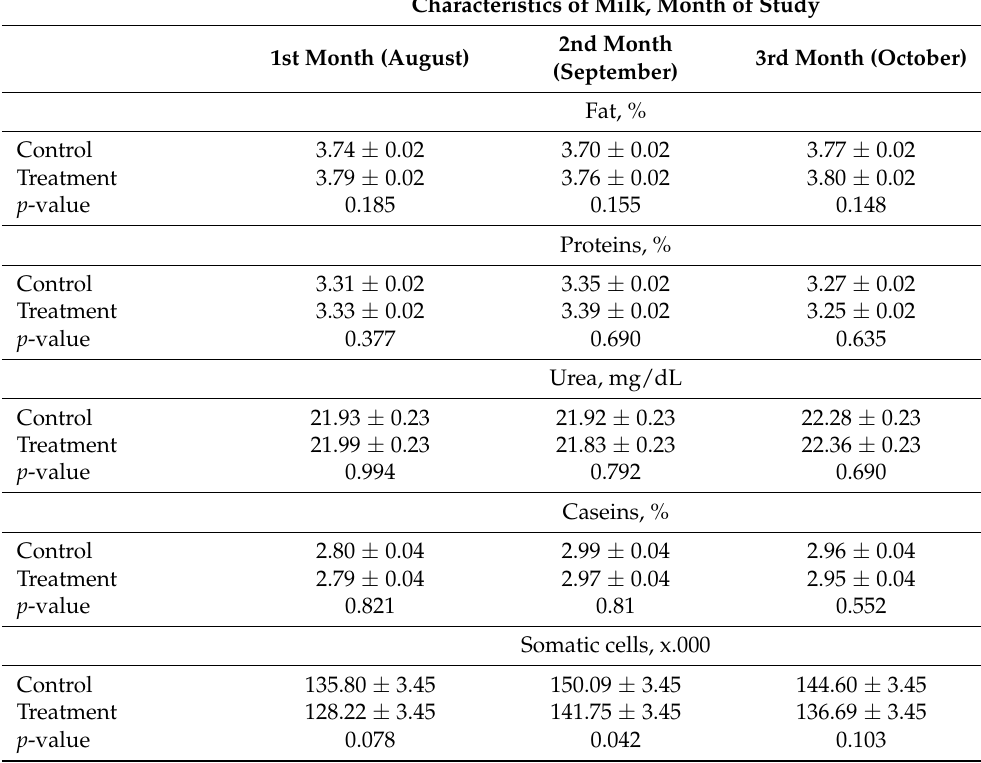
Table 8. Milk quality parameters in Control and Treatment groups.